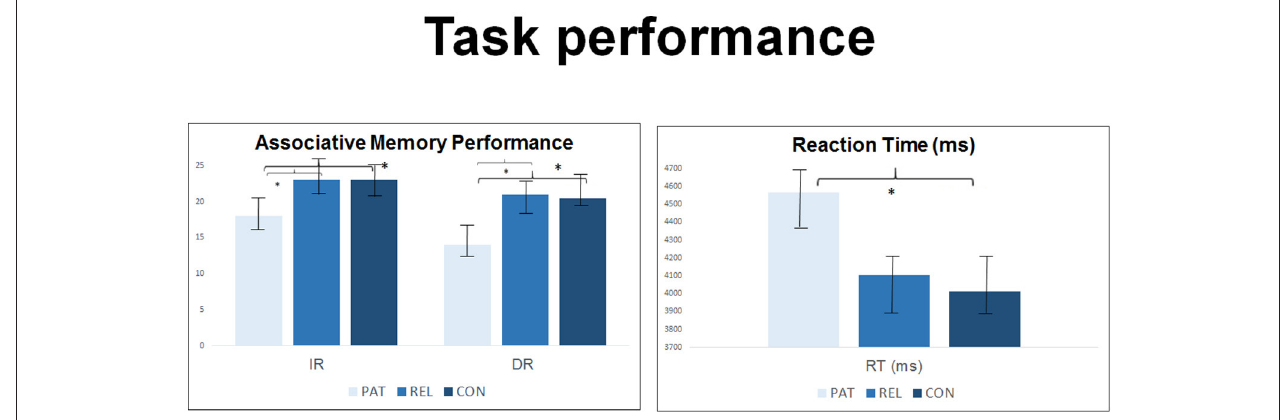
FIGURE 2 | Group comparison in n = 27 controls, n = 23 first-degree relatives and n = 27 SZ patients regarding accuracy and reaction time of the face-name-association-task during the acquisition of an fMRI sequence and during post-scanning debriefing. M , mean; SD , standard deviation. *Indicates statistial